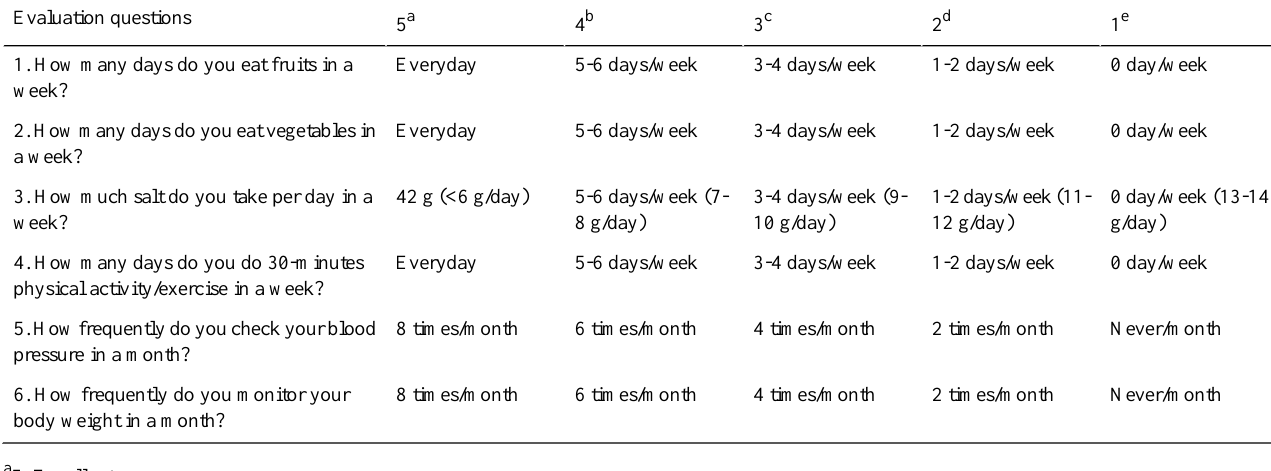
Table 1. Questionnaire for the evaluation of behavioral